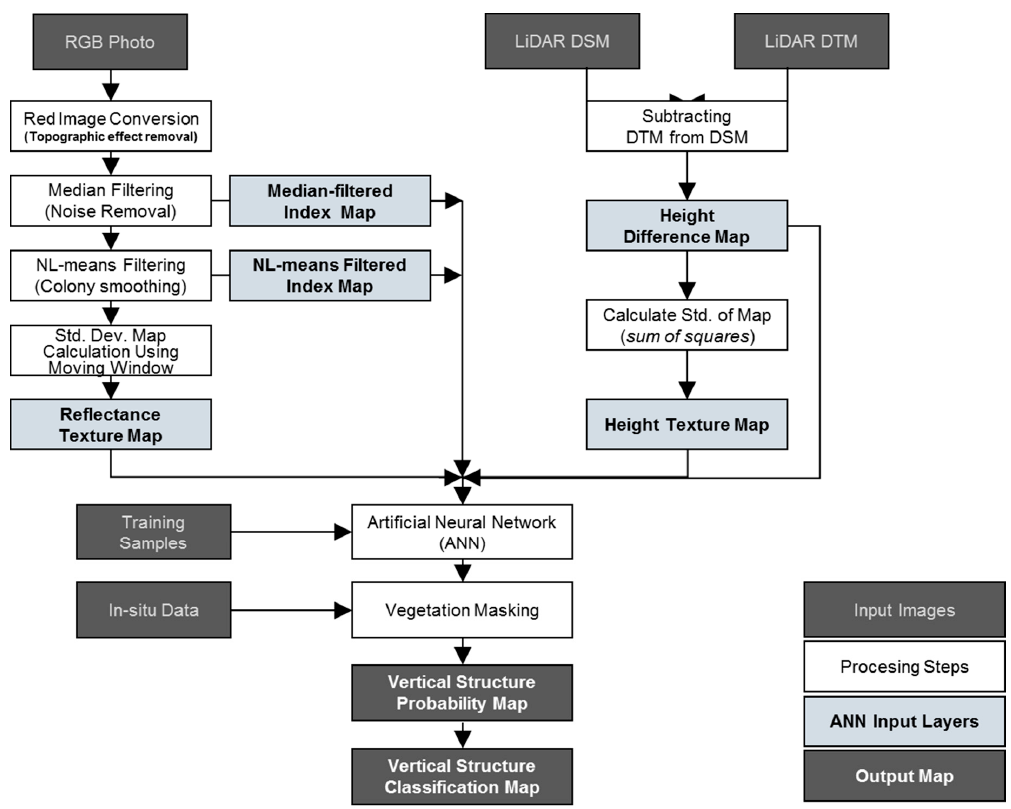
Figure 4. Detailed workflow used to classify the forest vertical structure from RGB orthophoto and lidar data using a machine learning